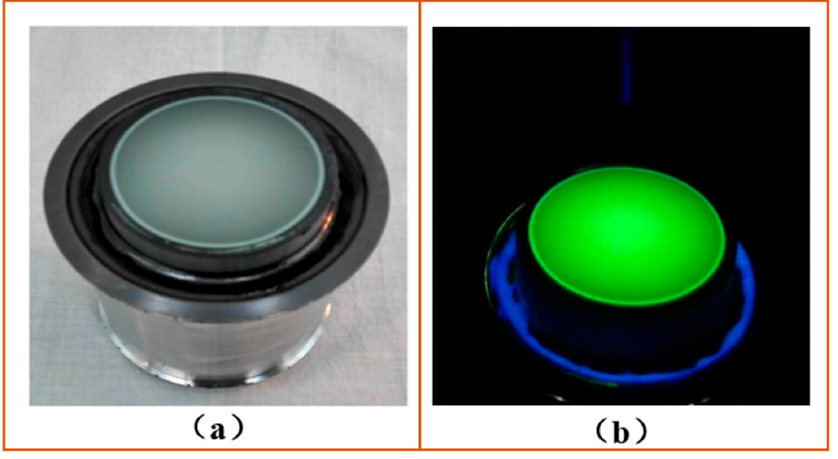
Figure 4. Fluorescent screen assembly and light emission: ( a ) planar fluorescent screen assembly;